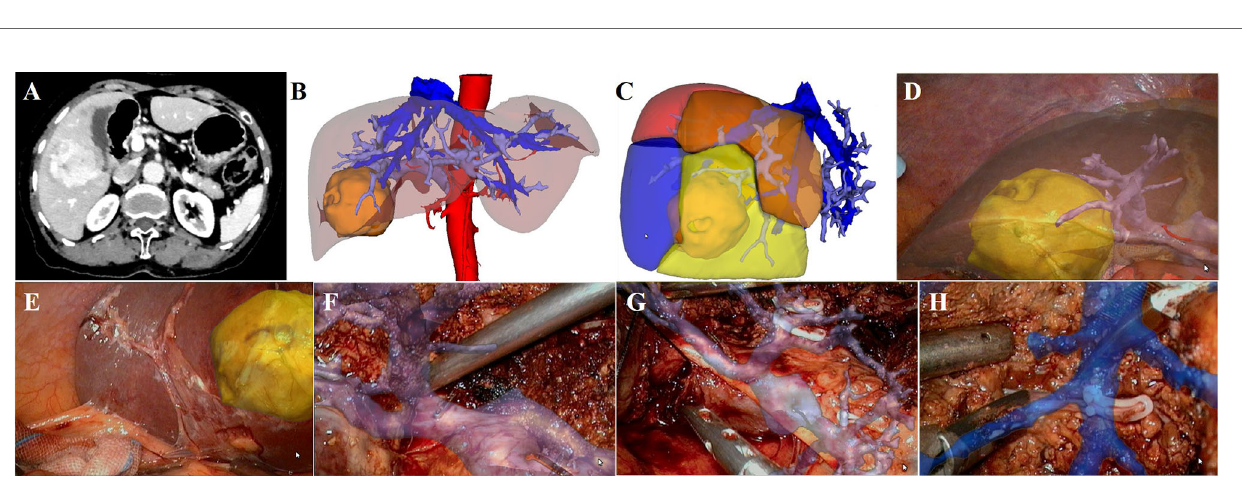
FIGURE 4 | LARN-assisted S5+6 segmentectomy. (A) , abdominal contrast-enhanced CT scan revealed a mixed density lesion in the right liver with heterogeneous enhancement. (B) , the lesion was located in the S5 and S6 from 3D visualization. (C) , the resected liver volume was 228.52 ml (26.57%) based on simulated hepatectomy. (D, E) , 3D models were projected onto the liver surface to show the relationship between the lesion and PVs. (F) , intraoperative navigation of the PV branch of S5. (G) , intraoperative navigation of the PV branch of S6. (H) , intraoperative navigation of middle hepatic